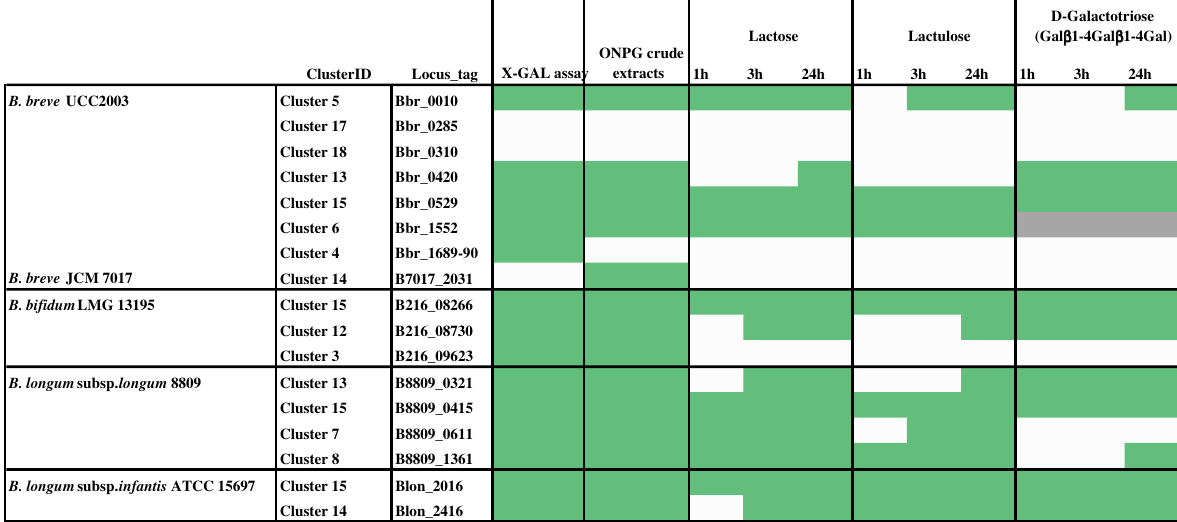
Table 4 Hydrolysis performance of the 17 cloned β-galactosidases tested on substrates lactose, lactulose and d -galactotriose